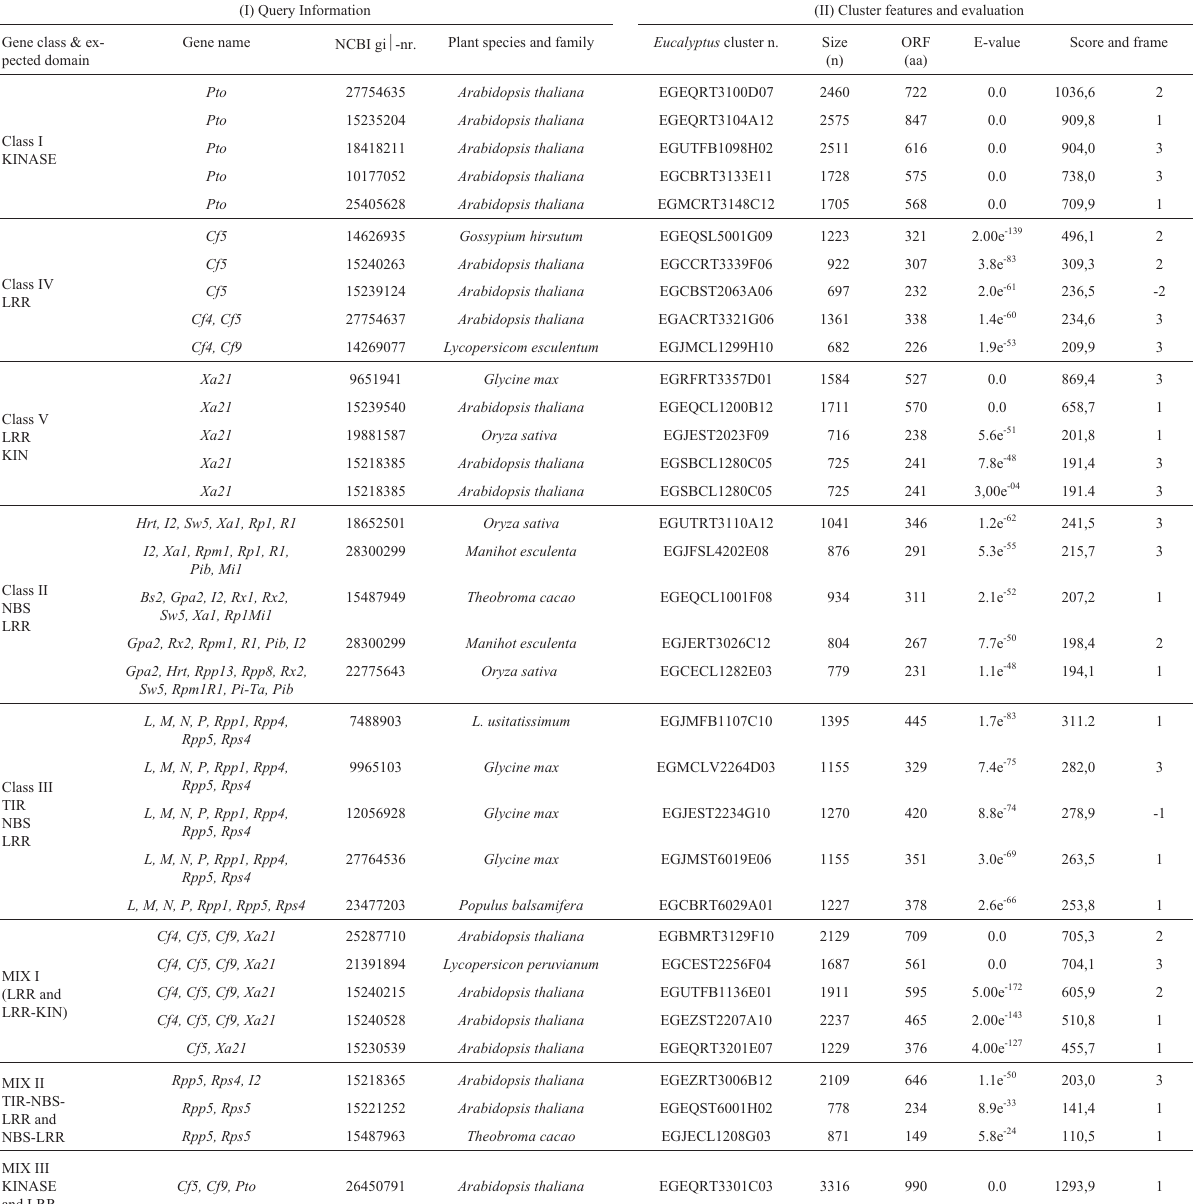
Table 2 - Blast results and sequence evaluation of Eucalyptus R genes, including the best matches of each R gene and MIX classes: (I) data about the query: gene class and name, NCBI gi (cid:1) -number, species and family. (II) Features and evaluation results of Eucalyptus clusters related to R-genes: cluster number, cluster size in nucleotides (n), ORF (Open Reading Frame) size in amino-acids (aa), e-value; score and frame. (I)QueryInformation (II)Clusterfeaturesandevaluation NCBIgi (cid:1) -nr. Plantspeciesandfamily Eucalyptus